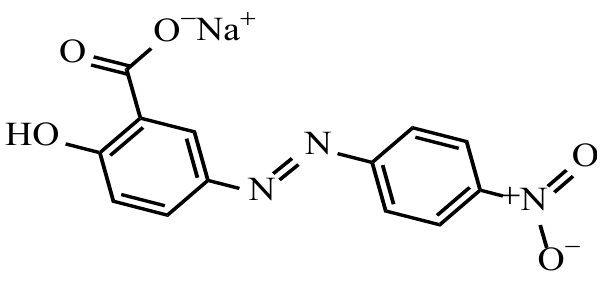
Fig. 1. Molecular structure of alizarine yellow